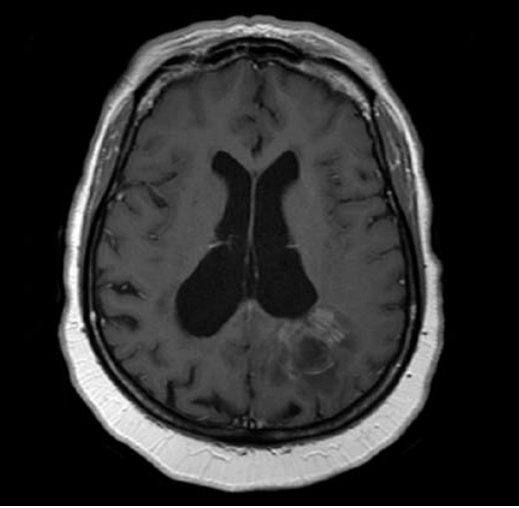
Balo’s concentric sclerosis. T1- weighted MRI of a 60- year-old woman pre- senting with a typical image of Balo’s con- centric sclerosis. The concentric lesion ap- pears to extend cen- trifugally by adding rims of myelin break- down (personal